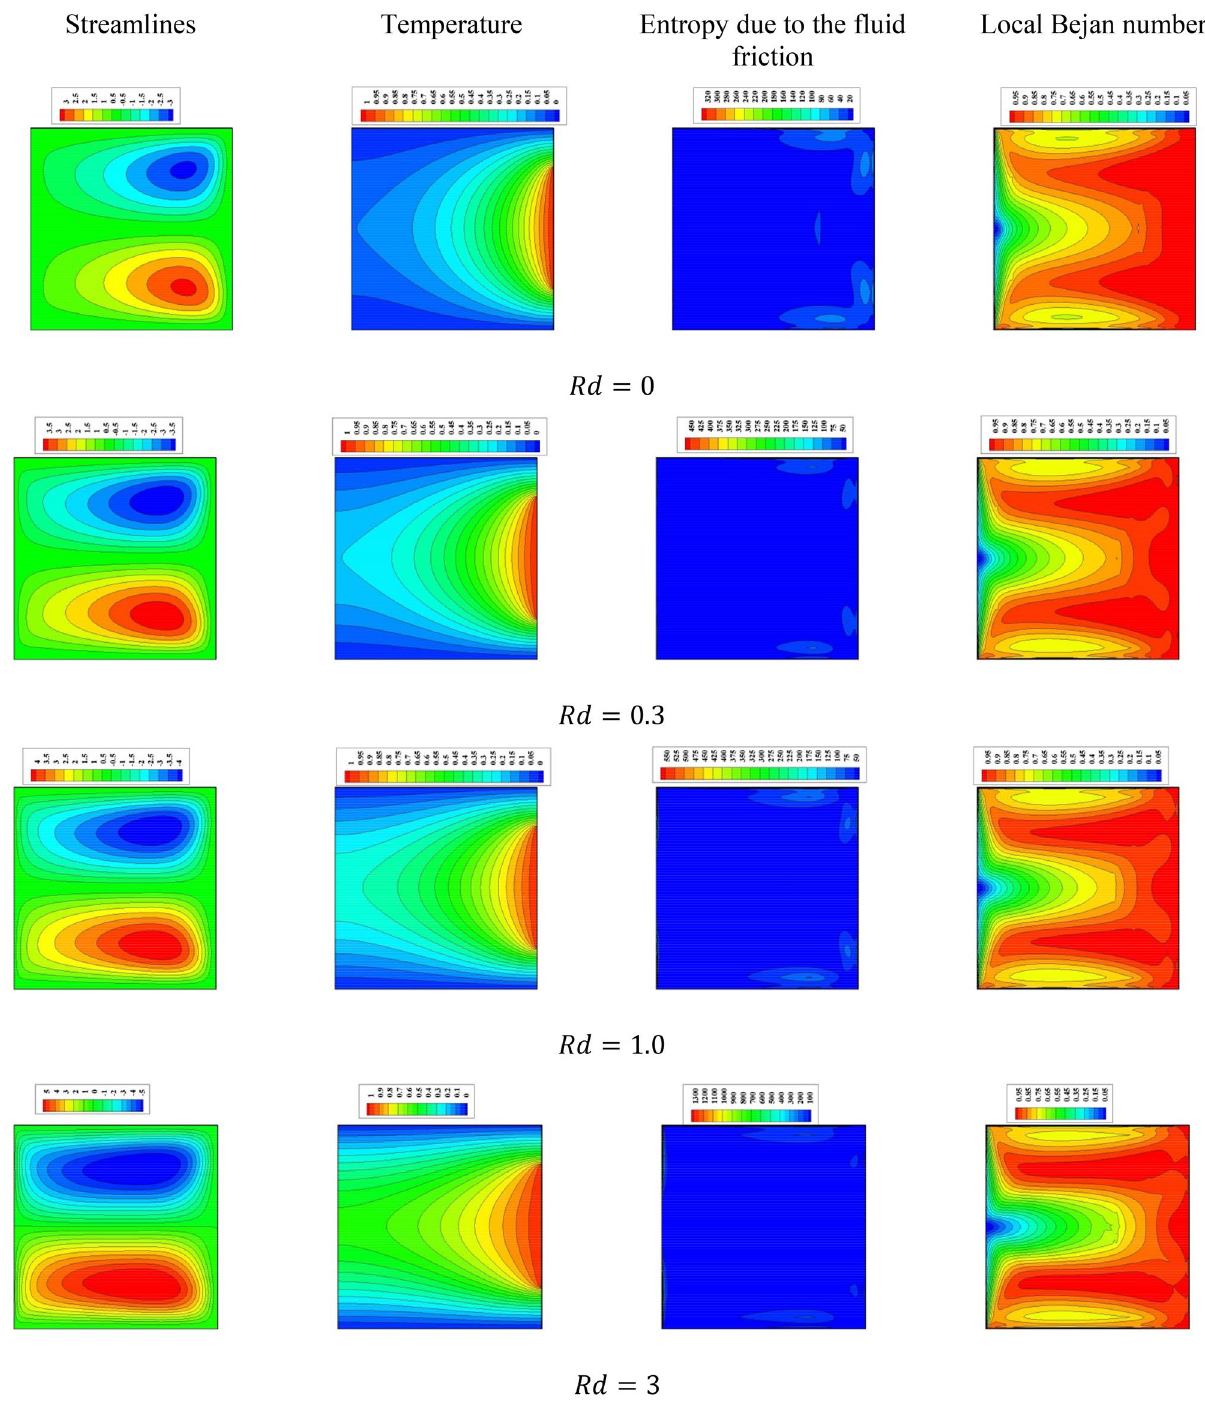
Figure 4. Impacts of the radiation parameter R on the fluid flow, temperature distributions and entropy generation at Ra = 10 5 , Da = 10 − 3 , b = 0.6, d = 0.5, Ma = 1000, β = 0.95, τ = 1, φ = 2%, N = 0.91, � = 10 − 4 , γ = 90